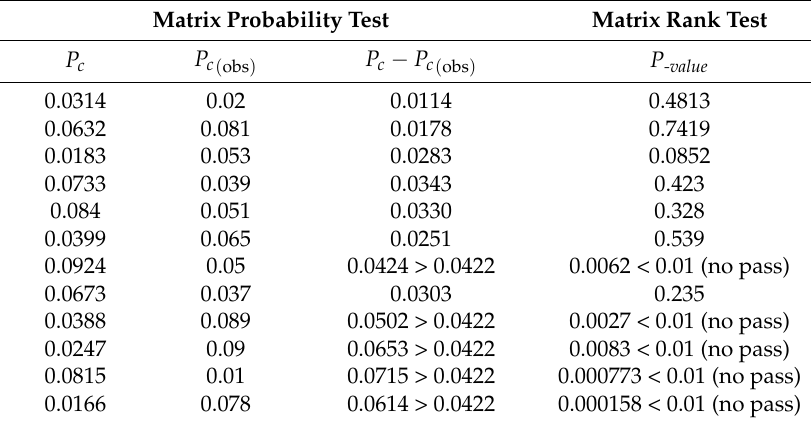
Table 1. Verifying the accuracy of the probability test